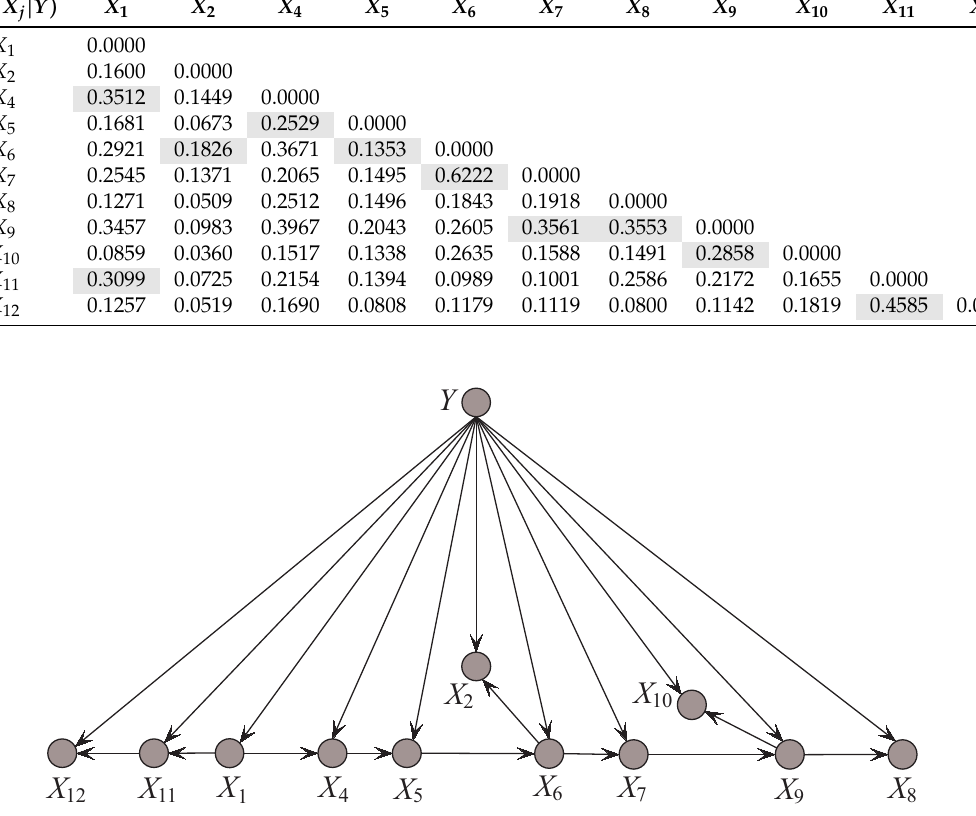
Figure 7. The topology of TAN corresponding to the CMI matrix shown in Table